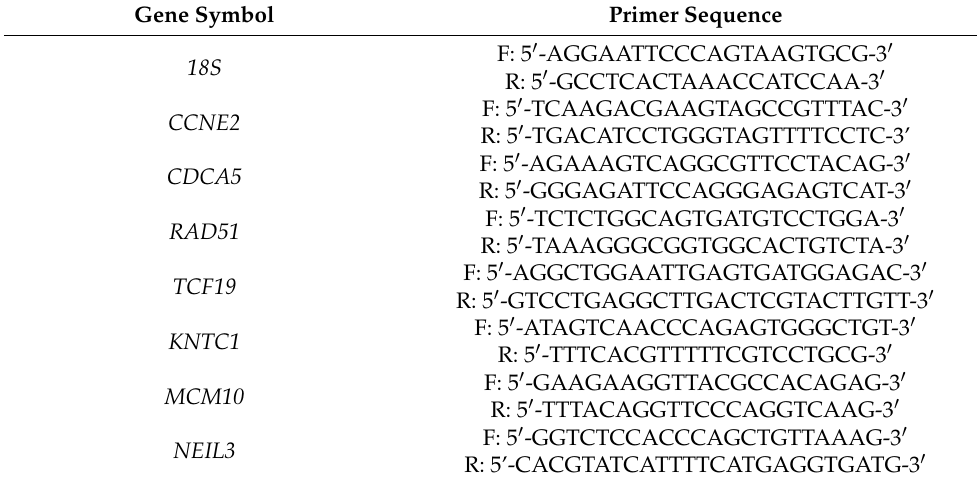
Table 1. Primer sequences for